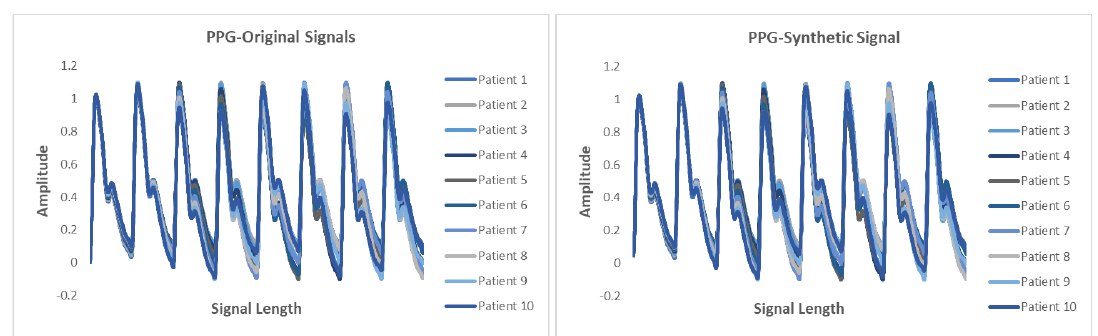
Figure 8. Comparison between original and synthetic ECG signals.